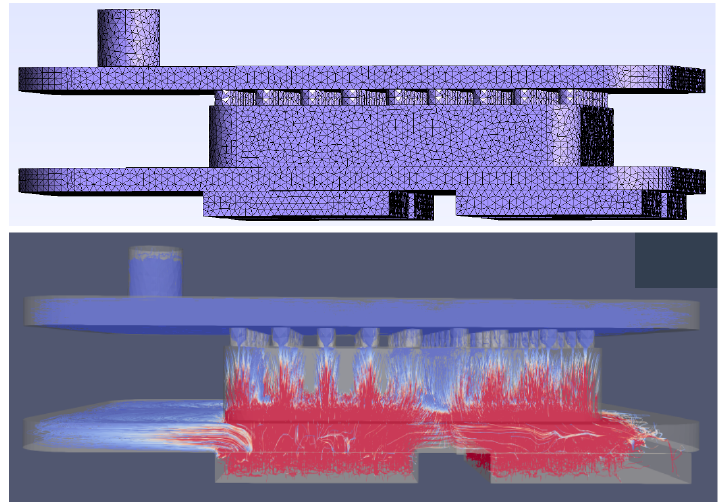
Figure 9. Computational domain and streamlines corresponding to the red box in Figure 4. The inlet is at the bottom through four membranes, and the outlet is at the top through the vertical cylinder. The maximal velocity is 3.5 cm/s (shown in red).